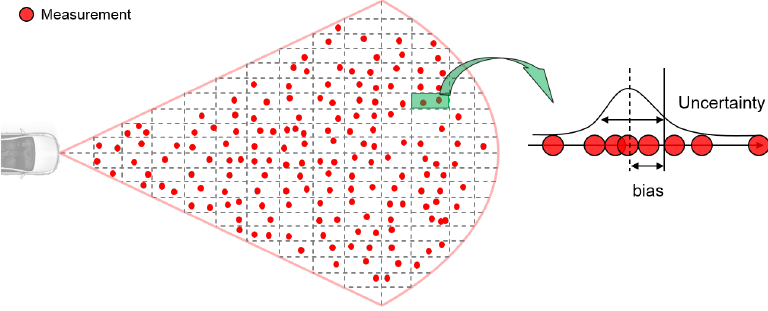
Figure A1. The concept of grid cells based sensor